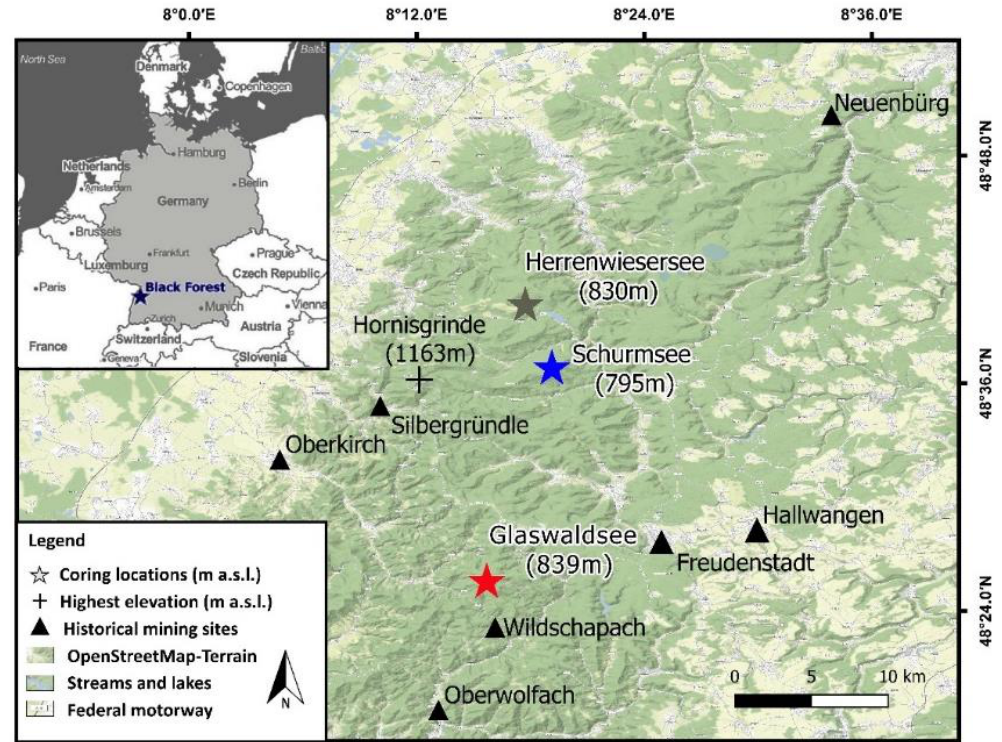
Figure 1. Map of the northern Black Forest showing the coring locations at Herrenwiesersee (grey star, Rydberg et al. [33]), Schurmsee (blue star), and Glaswaldsee (red star), as well as the topography, former mining sites and present-day land cover. Inset: localization of the study area in central Europe.